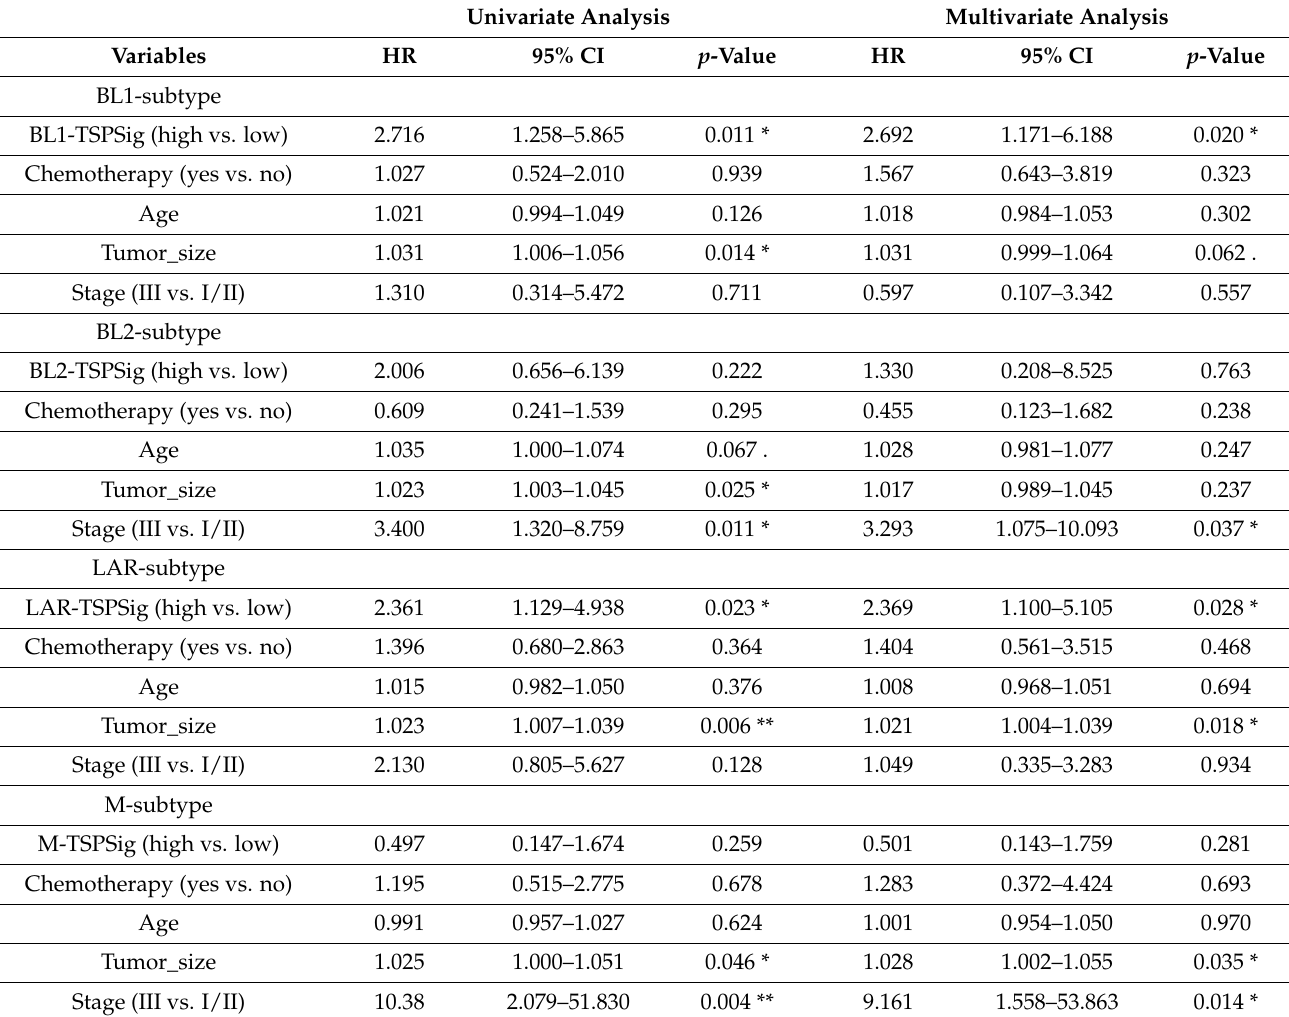
Table 2. Univariate and multivariate Cox regression analyses of the OS in each TNBC subtype. Univariate Analysis Multivariate